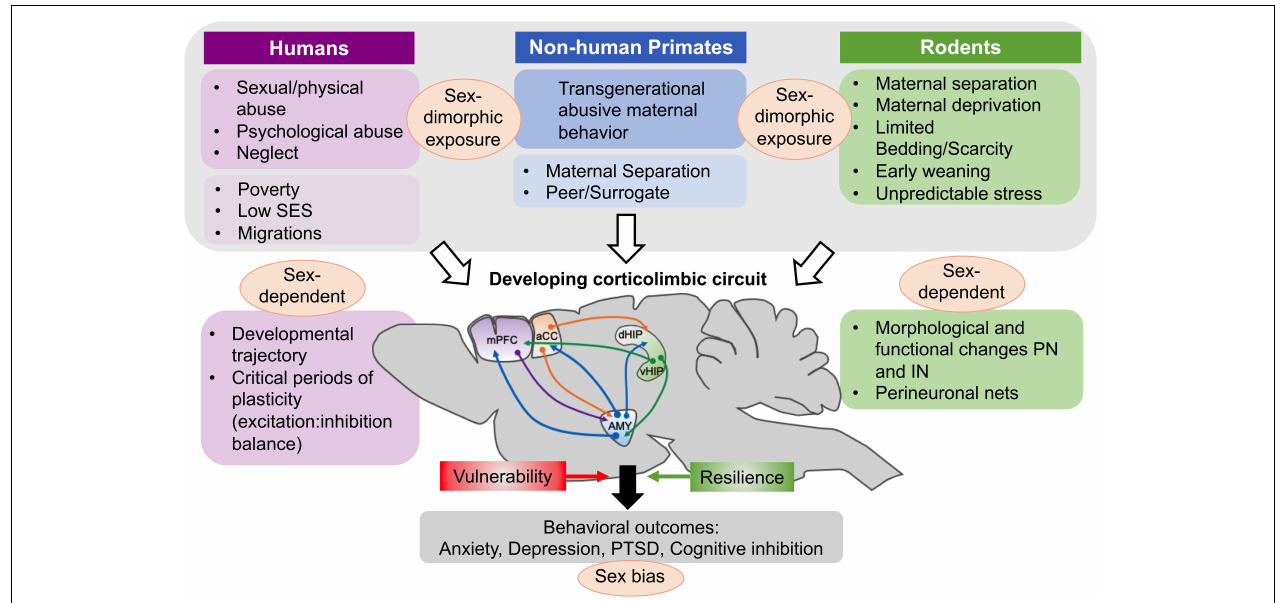
FIGURE 1 | Factors associated with early life adversity in humans and experimental procedures in non-human primate and rodent studies that have been used in studies of ELS and adversity. Several, but not all of these factors and procedures produce a sexually dimorphic exposure in the offspring. In humans, poverty, being raised in a low SES milieu or being part of migratory movements might be less directly associated with sex-differences in exposure. These modalities causing ELS have in common that they occur during a critical developmental period for the corticolimbic circuit, affecting the normal developmental trajectory as well as critical periods of plasticity characterized by changes in the balance of excitation and inhibition in amygdala (AMY), medial prefrontal cortex (mPFC), anterior cingulate cortex (ACC), and hippocampus (dorsal and ventral). At the cellular level, both morphological and functional changes in principal neurons (PN) and inhibitory interneurons (IN) have been documented after ELS and these vary as a function of the sex of the offspring. The important role of perineuronal nets (PNNs) in stabilizing synaptic inputs on interneurons and closing critical periods of plasticity is also modified by ELS. Based on anatomical, morphological and functional changes triggered by ELS, behavioral outcomes of ELS and childhood adversity are further modified by genetic risk factors and epigenetic changes that confer risk and resilience to the offspring. In all three species examined in this paper, behavioral consequences of early adversity are differentiated according to sex and specific behavioral categories. Figure adapted from Murthy and Gould